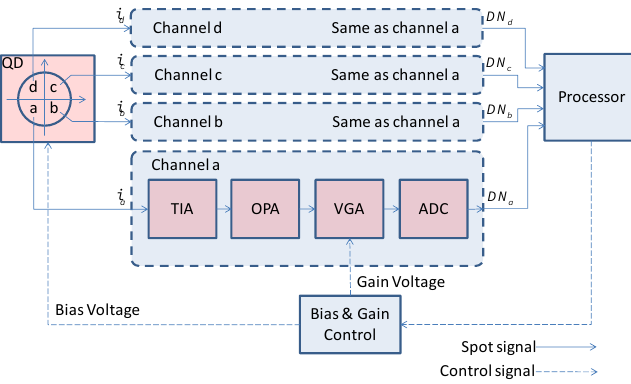
Figure 3. Four-quadrant PIN detector and post-processing circuit schematic.